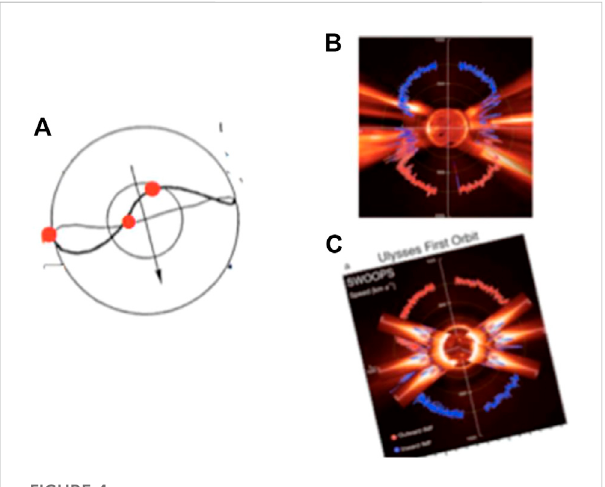
FIGURE 4 (A) The magnetic equator on the spherical source surface during a weakly disturbed condition (near the end of the cycle in this case); it is taken from Figure 3); the dots show the assumed location of equatorial streams. (B) The observed distribution (Figure 2C). (C) The constructed distribution of (B)